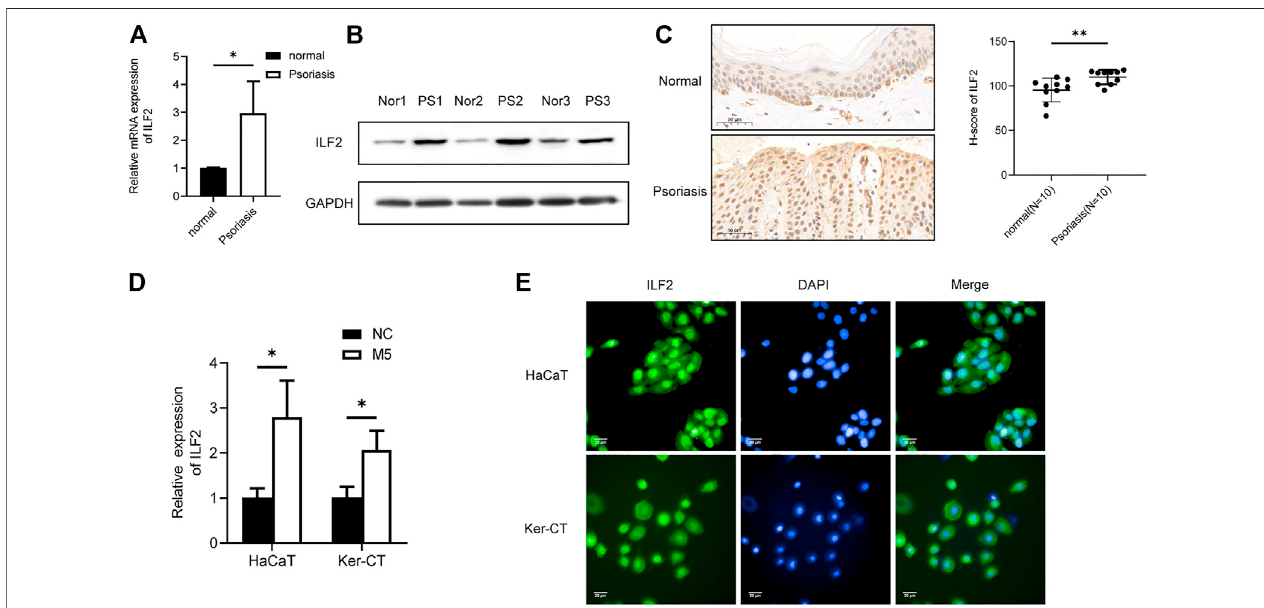
FIGURE5| ILF2ishighlyexpressedinpsoriaticlesions. (A) ThemRNAexpressionlevelofILF2inpsoriatictissues( n =3). (B) TheproteinexpressionlevelofILF2in psoriatictissues( n =3). (C) TheexpressionofILF2innormalandpsoriatictissueswasdetectedbyIHC( n =10).TheH-scorewascalculatedbasedonthepercentageof ILF2+ cells and staining intensity. (D) The expression level of ILF2 in M5-treated HaCaT and Ker-CT cells. (E) Subcellular localization of ILF2 in HaCaT and Ker-CT cells. Data are shown as the means ± SD, * p < 0.05. All experiments were repeated at least three